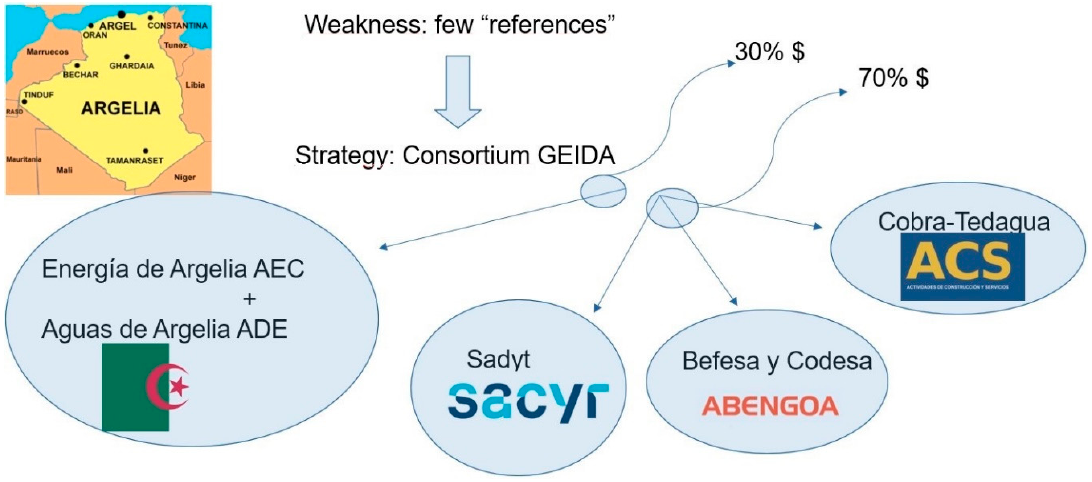
Figure 3. GEIDA consortium. Source: Own elaboration.